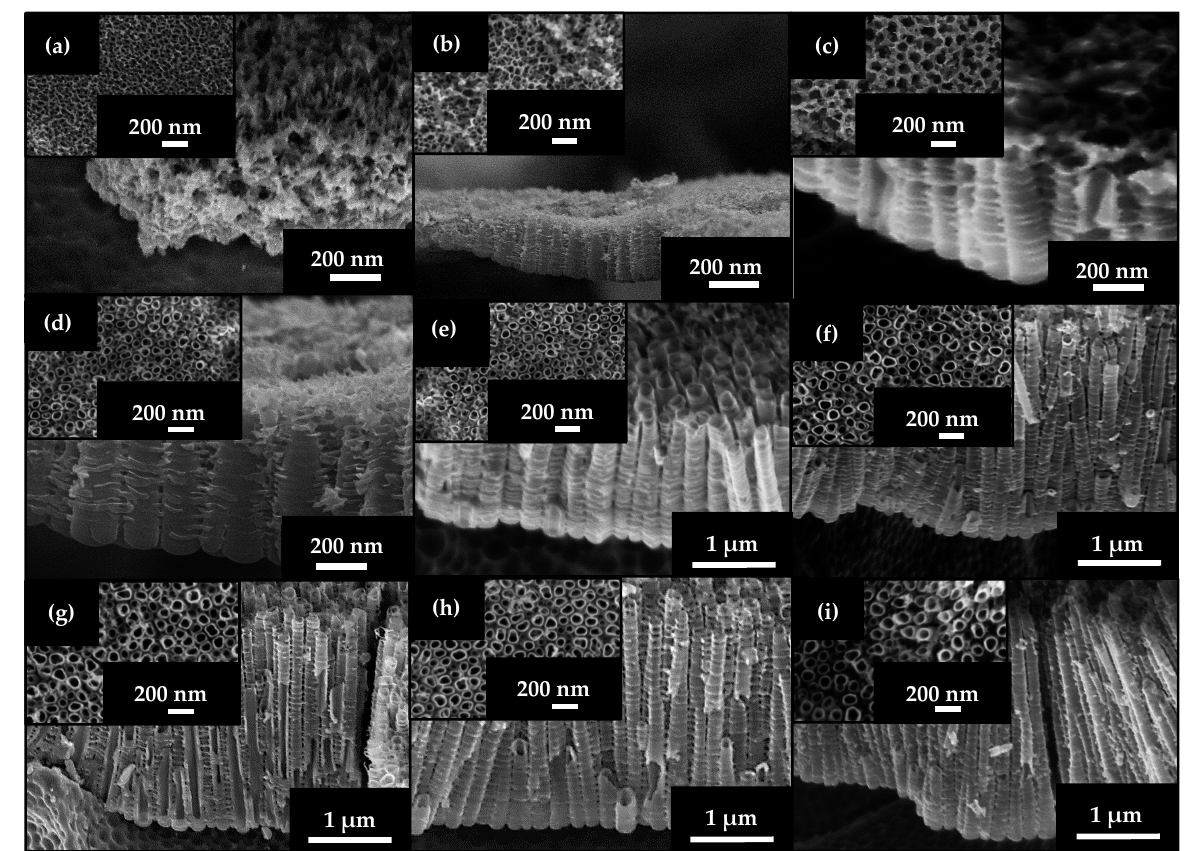
Figure 5. FESEM images of the anodized TiO 2 at different anodization times: ( a ) 1, ( b ) 15, ( c ) 30, ( d ) 60, ( e ) 90, ( f ) 120, ( g ) 180, ( h ) 360, and ( i ) 720 min. All anodization was performed at 20 V in glycerol-water added to it 0.5 wt.% NH 4 F.